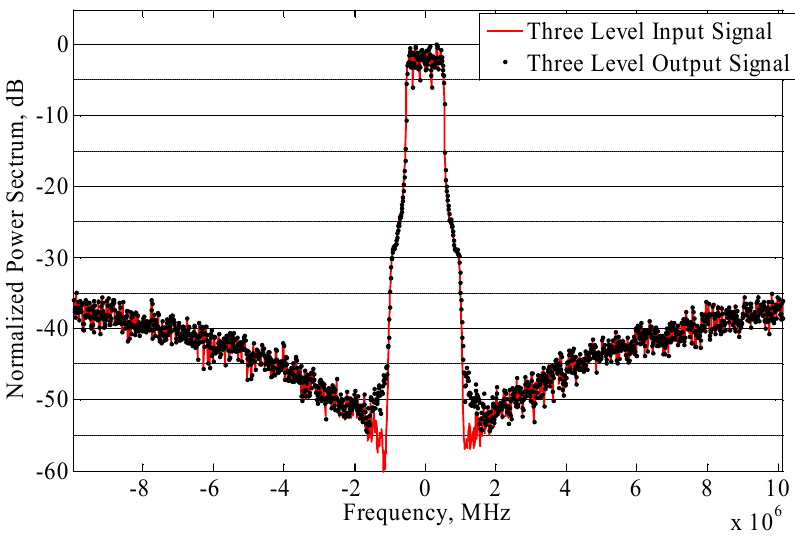
Figure 7. Normalized input and output three-level CxDSM signal.